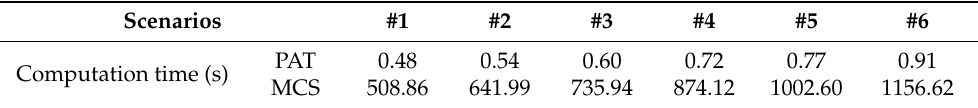
Table 4. Run time comparison (10-min interval around 00:00 h during a working day in